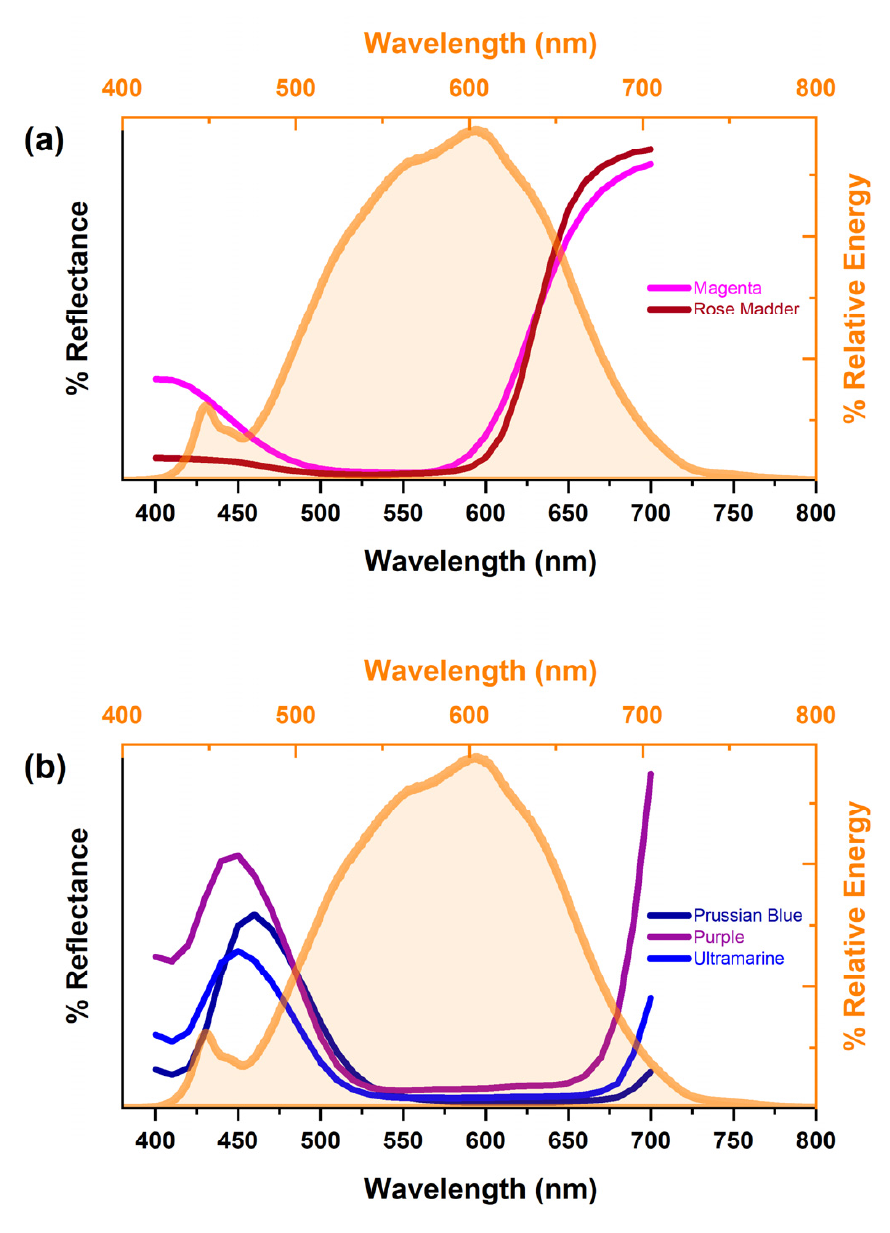
Figure 9. Reflectance curves for some of Dr. Ph. Martin’s Synchromatic Transparent Water Colors. Magenta and Rose Madder ( a ) experienced a direct correlation between reflectance minima and LED spectra distribution. Prussian Blue, Purple, and Ultramarine ( b ) exhibited an inverse relationship to their reflectance minima.